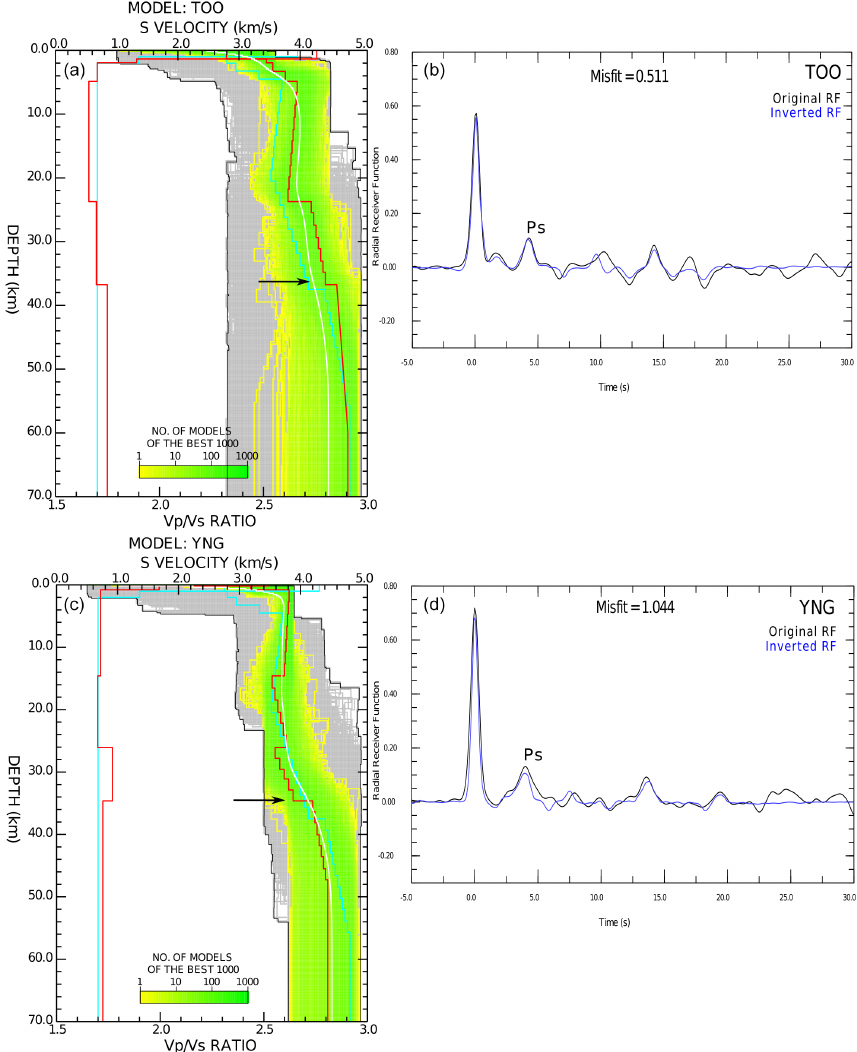
Figure 8. (a, c) Seismic velocity models for TOO and YNG stations obtained from the neighbourhood algorithm. (b, d) Comparison between the observed stacked and the predicted receiver functions from the NA inversion. See the caption of Fig. 7 for more